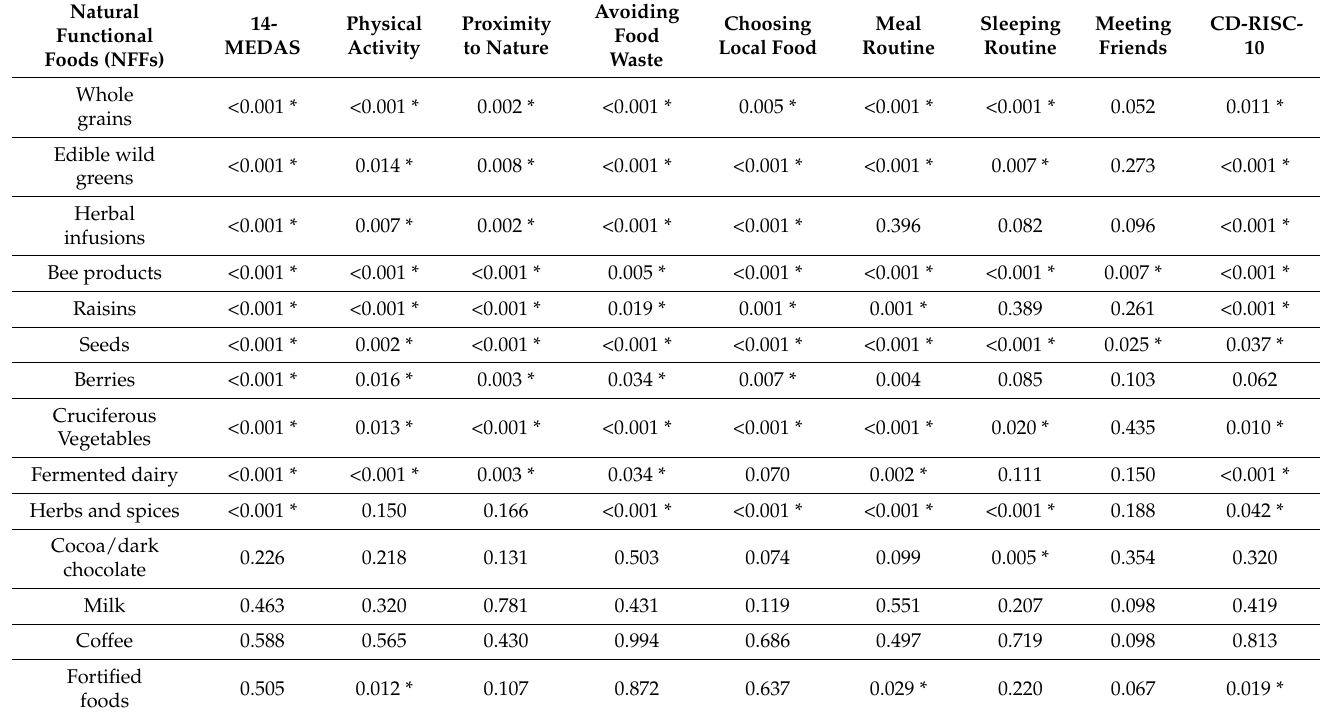
Table 1. p -values of the Spearman’s correlation coefficients of Natural Functional Foods (NFFs) with MD, MEDILIFE, and PsyR.